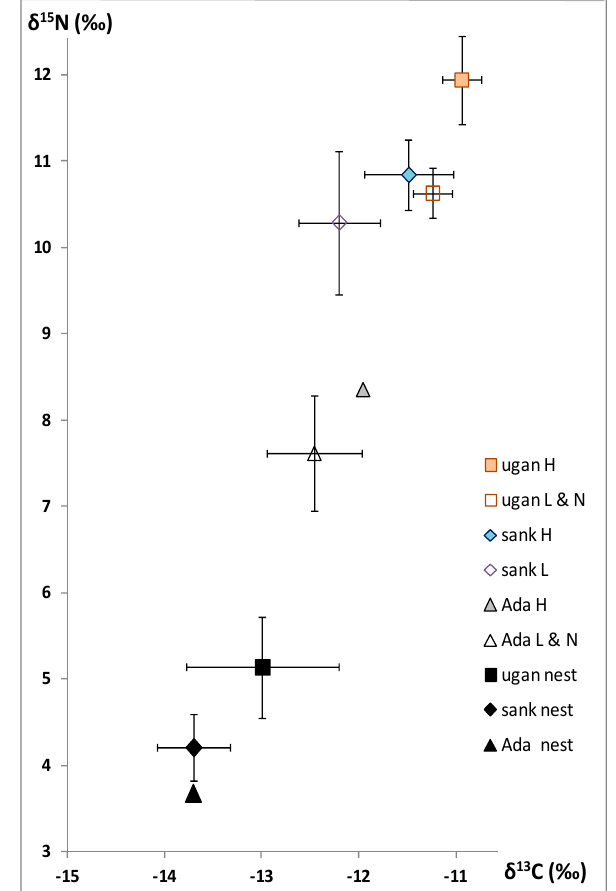
Figure 1. Plot of δ 15 N (‰) as function of δ 13 C (‰): ugan H = soldiers and workers heads of C. aff. ugandensis ; ugan L & N = larvae and alate nymphs of C. aff. ugandensis ; sank H = soldiers and workers heads of C. aff. sankurensis ; sank L = larvae of C. aff. sankurensis ; Ada H = workers heads of Adaiphrotermes sp ; Ada L &N = larvae and alate nymphs of C. Adaiphrotermes sp ; ugan nest = nest